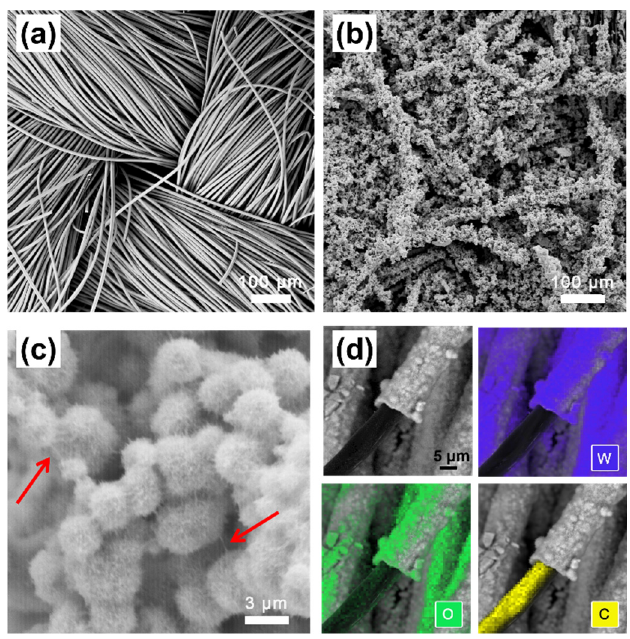
Figure 2. SEM images of ( a ) CC; ( b , c ) WO 3 /CC; and ( d ) element distribution of W, O, and C on the WO 3 /CC electrode.